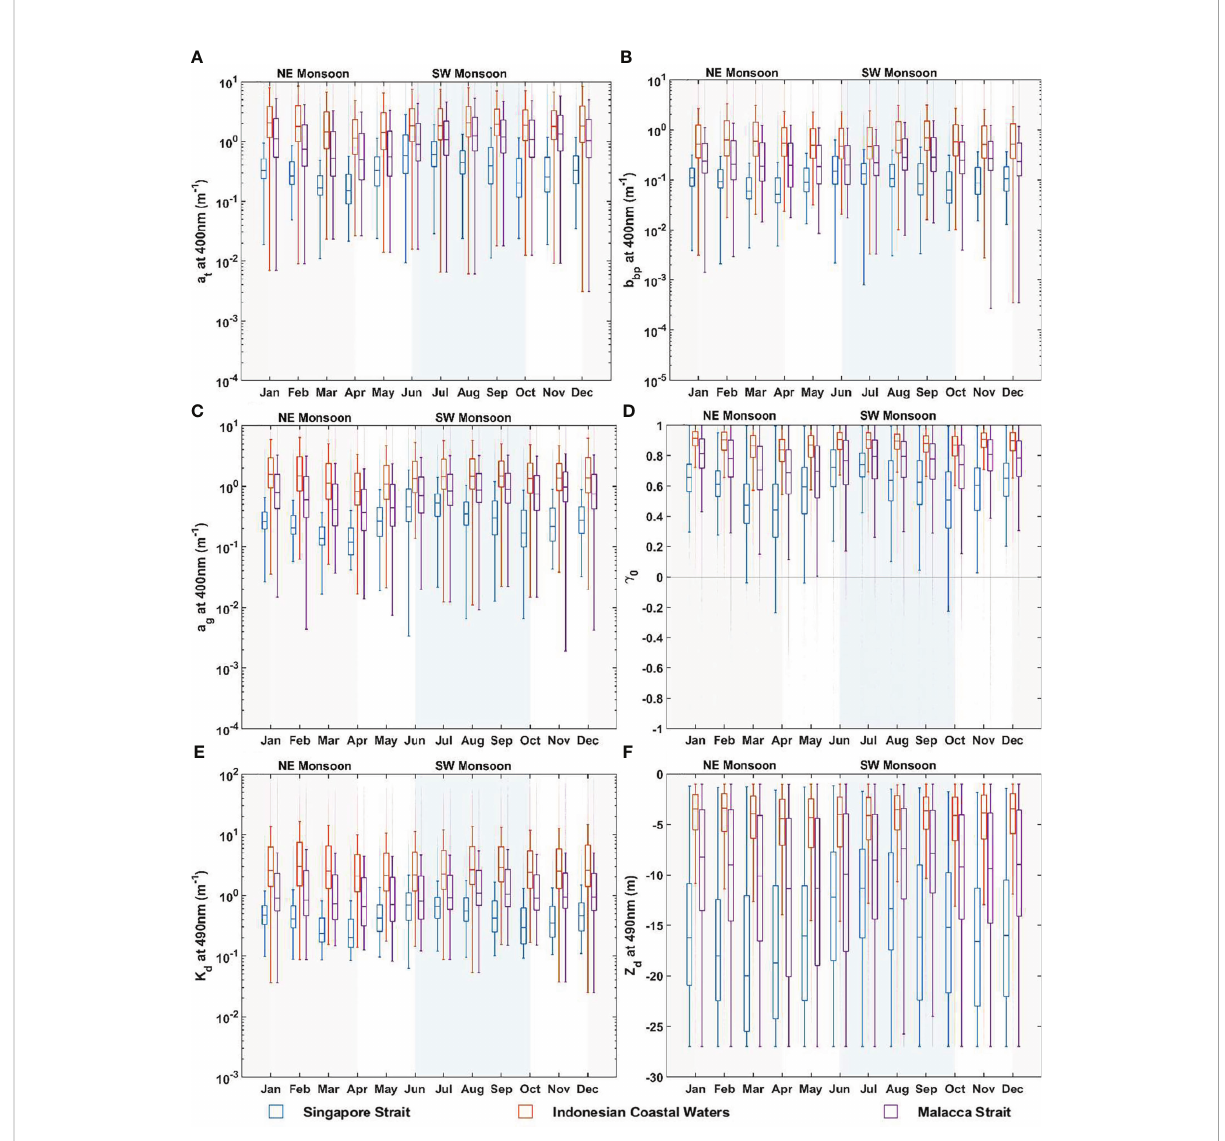
FIGURE 5 Box plots of monthly mean (2017-2020) values of bio-optical parameters across Singapore Strait, Malacca Strait, and Sumatran Coastal waters de fi ned in Figure 1. Bio-optical parameters derived from Sentinel OLCI were (A) Total absorption coef fi cient of light (a t ) at 400 nm. (B) Particulate backscattering (b bp ) at 400nm. (C) CDOM absorption coef fi cient (a g ) at 400 nm. (D) CDOM source index, g 0 (values ≥ 0.5 indicate the increasing dominance of terrigenous CDOM over CDOM of marine origin). (E) Diffuse attenuation coef fi cient of light (K d ) at 490 nm. (F) Depth of maximum penetration of light at 490 nm (Z d , 1% of the surface value). Box plot for the offshore marine waters is avoided here due to relatively lower and stable values of all the